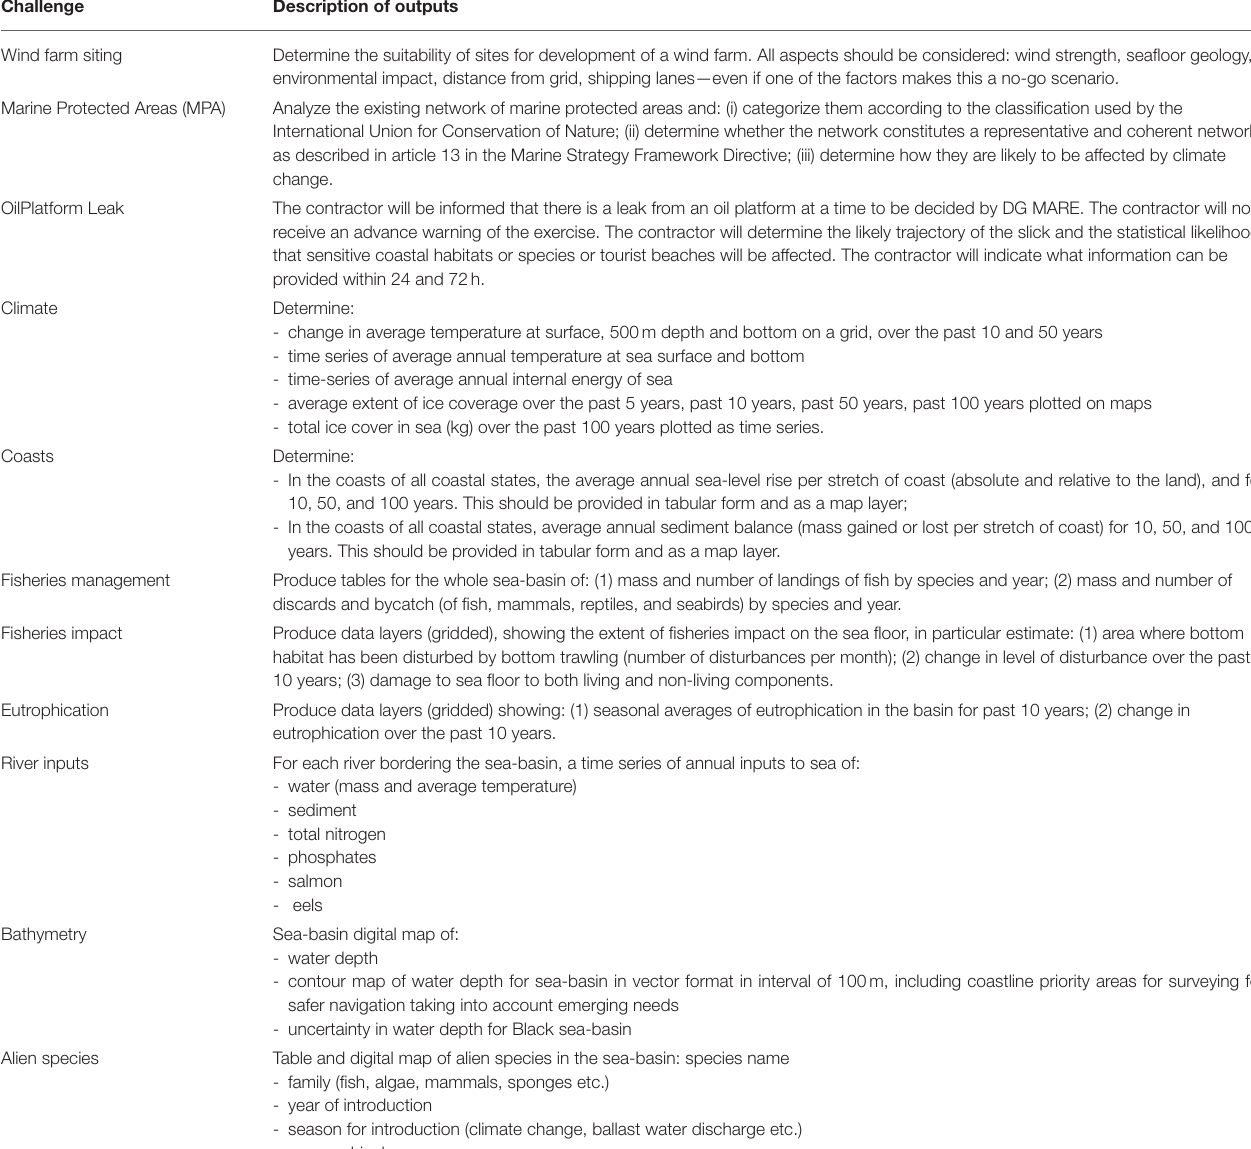
TABLE 5 | Description of the challenges that the checkpoints had to attempt with their corresponding expected outputs. Challenge